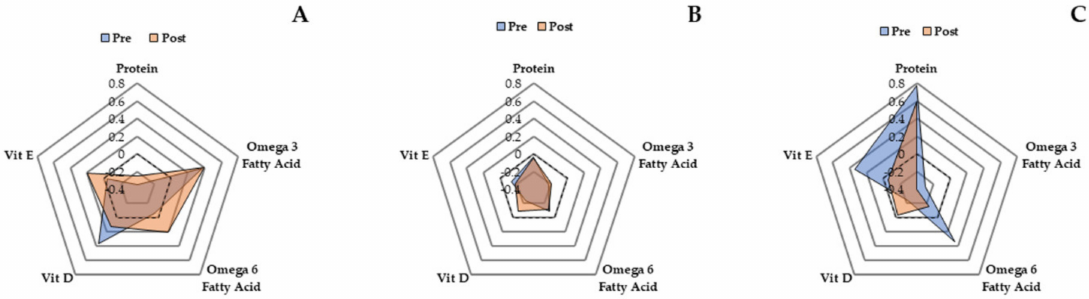
Figure 2. Radar graphs representing z-scores for five nutrients promoting anabolism at baseline and post intervention. Panels ( A – C ) represent SBF, LIPA, and control respectively.